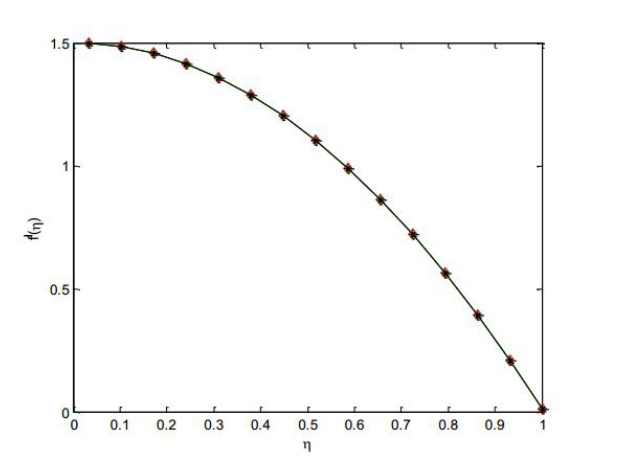
Figure 3. Variation of f ( η ) with the flow length